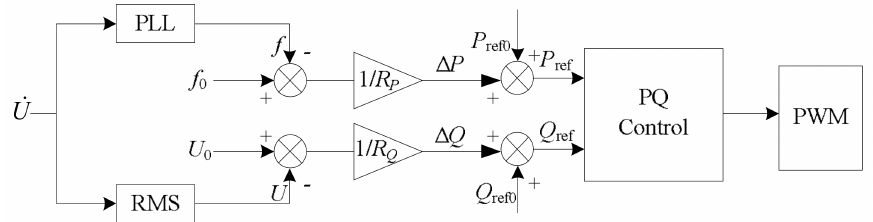
Figure 13. Improved PQ control